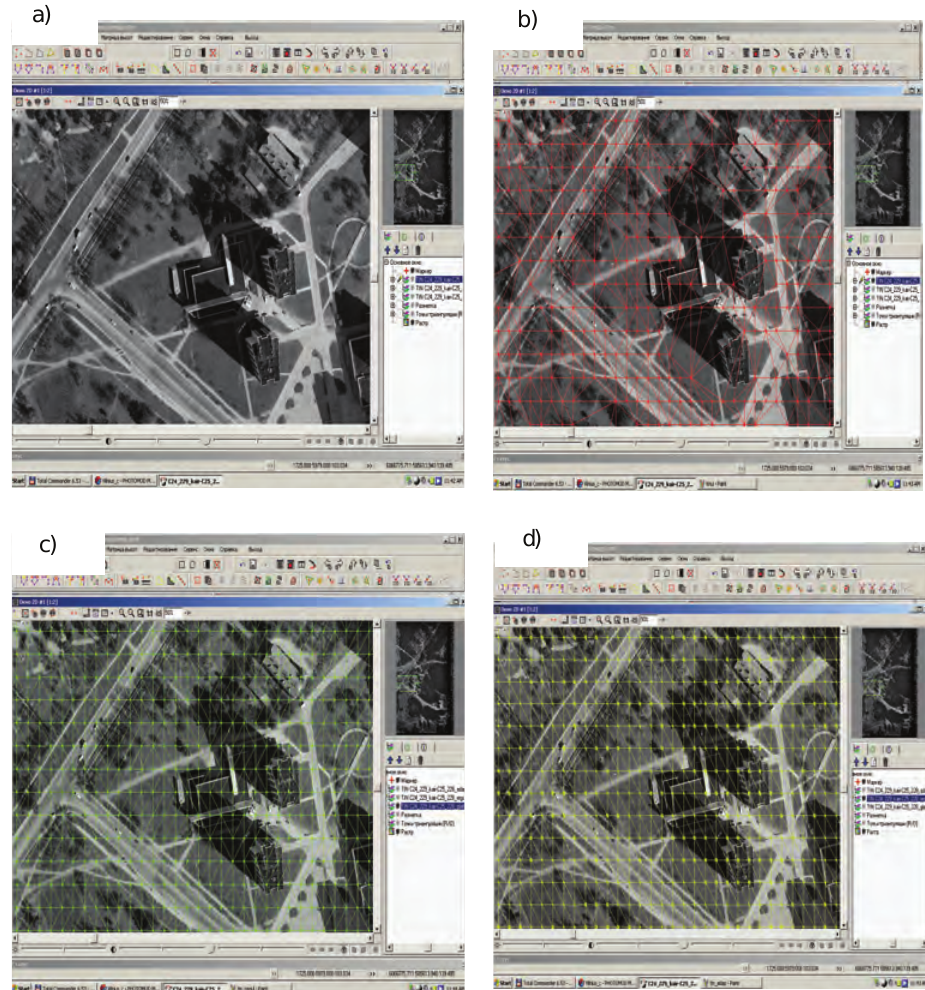
Fig. 2. Relief modeling: a) fragment of photogrammetric model, b) adaptive TIN, c) smooth, d)